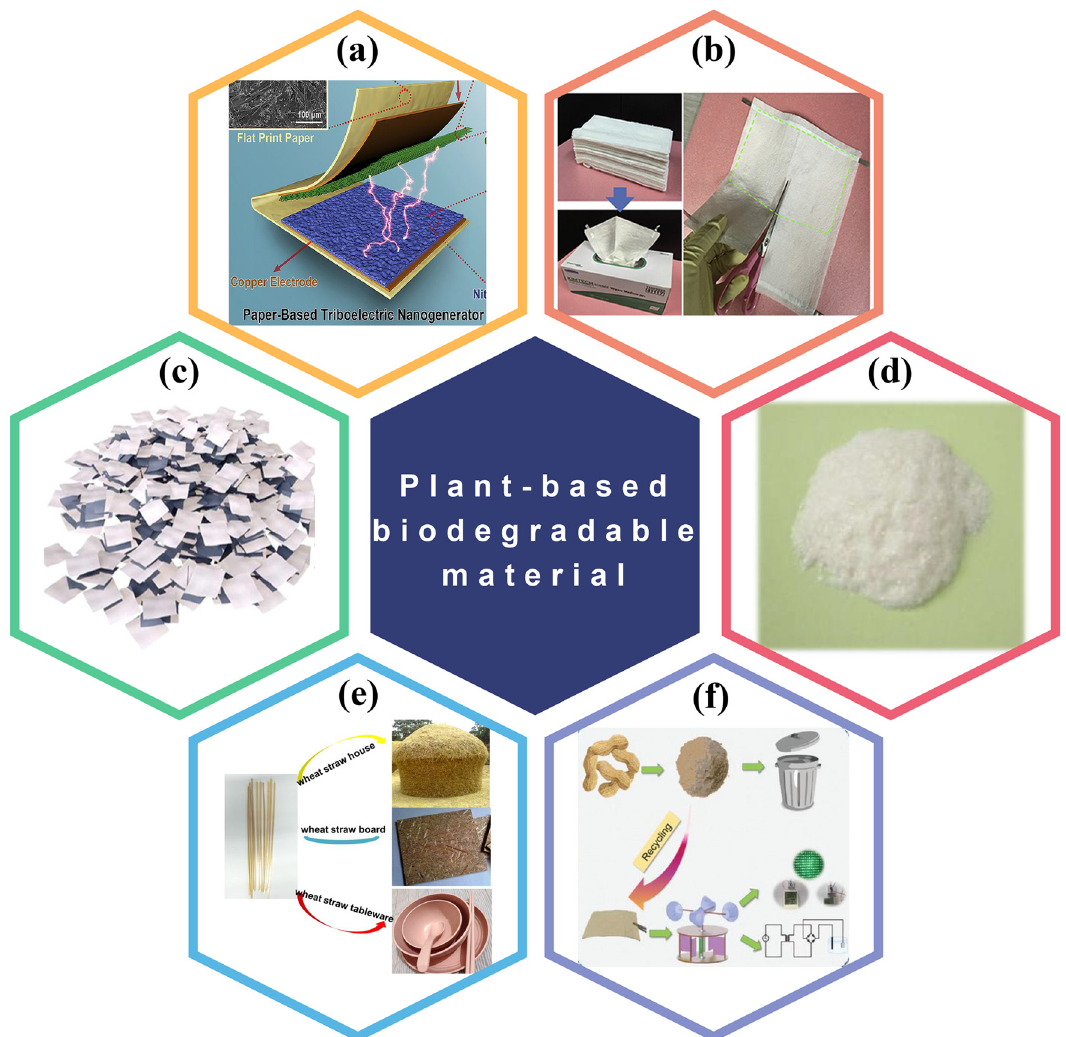
Figure 3. Plant-based biodegradable materials used in BD-TENG. ( a ) A TENG based on CCP and